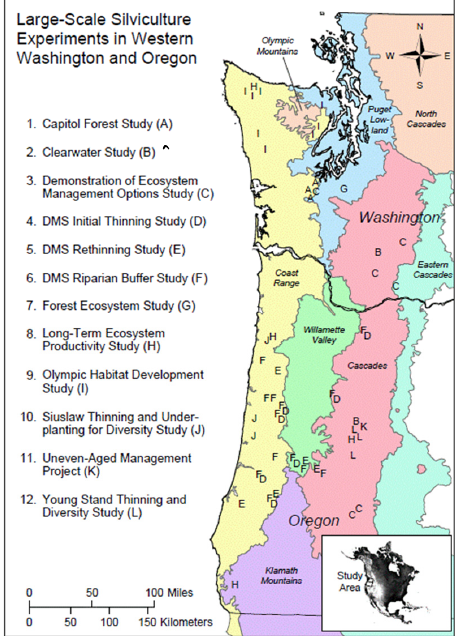
Figure 1. Distribution of locations in large-scale silviculture experiments (LSSEs) in western Oregon and Washington. Copies of a letter indicate multiple installations of a study. Note that each LSSE location shown may include multiple blocks, treatments, and replicates. The LSSE locations are superimposed on Omernik’s [10] level III ecoregions. For more details and more information about the studies, see [8] (Figure 1 is from [8]).